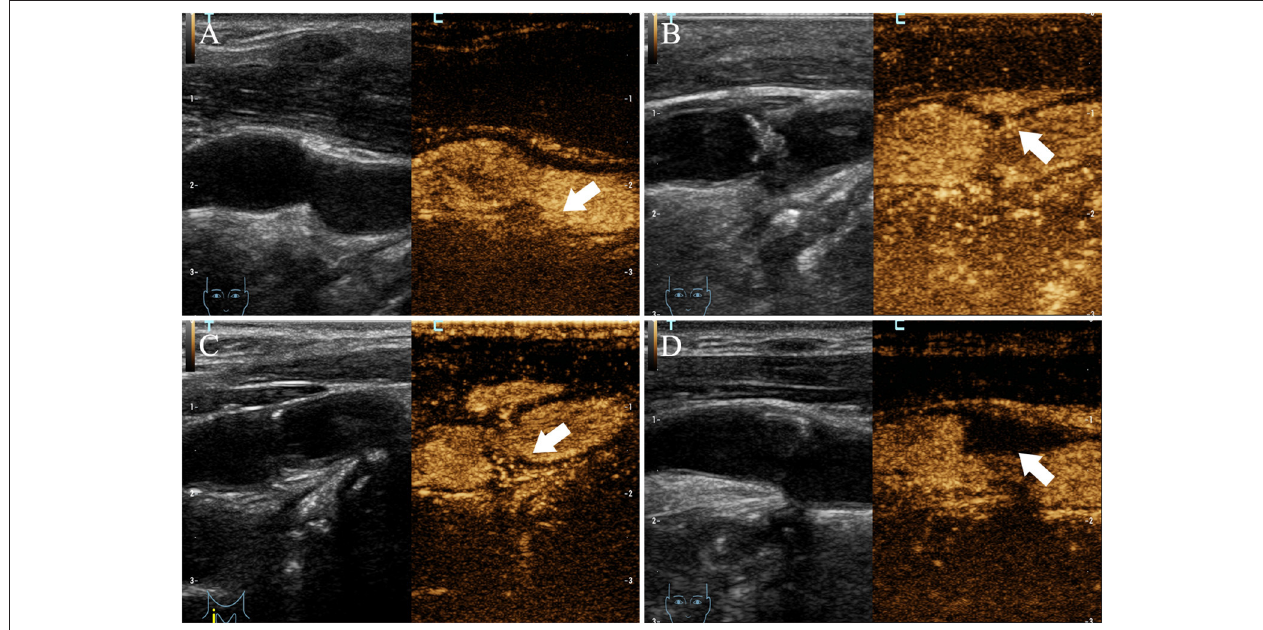
FIGURE 3 | Imaging manifestations of CaW using CEUS. (A–D) all have obvious contrast filling defects (arrows indicate filling defects).